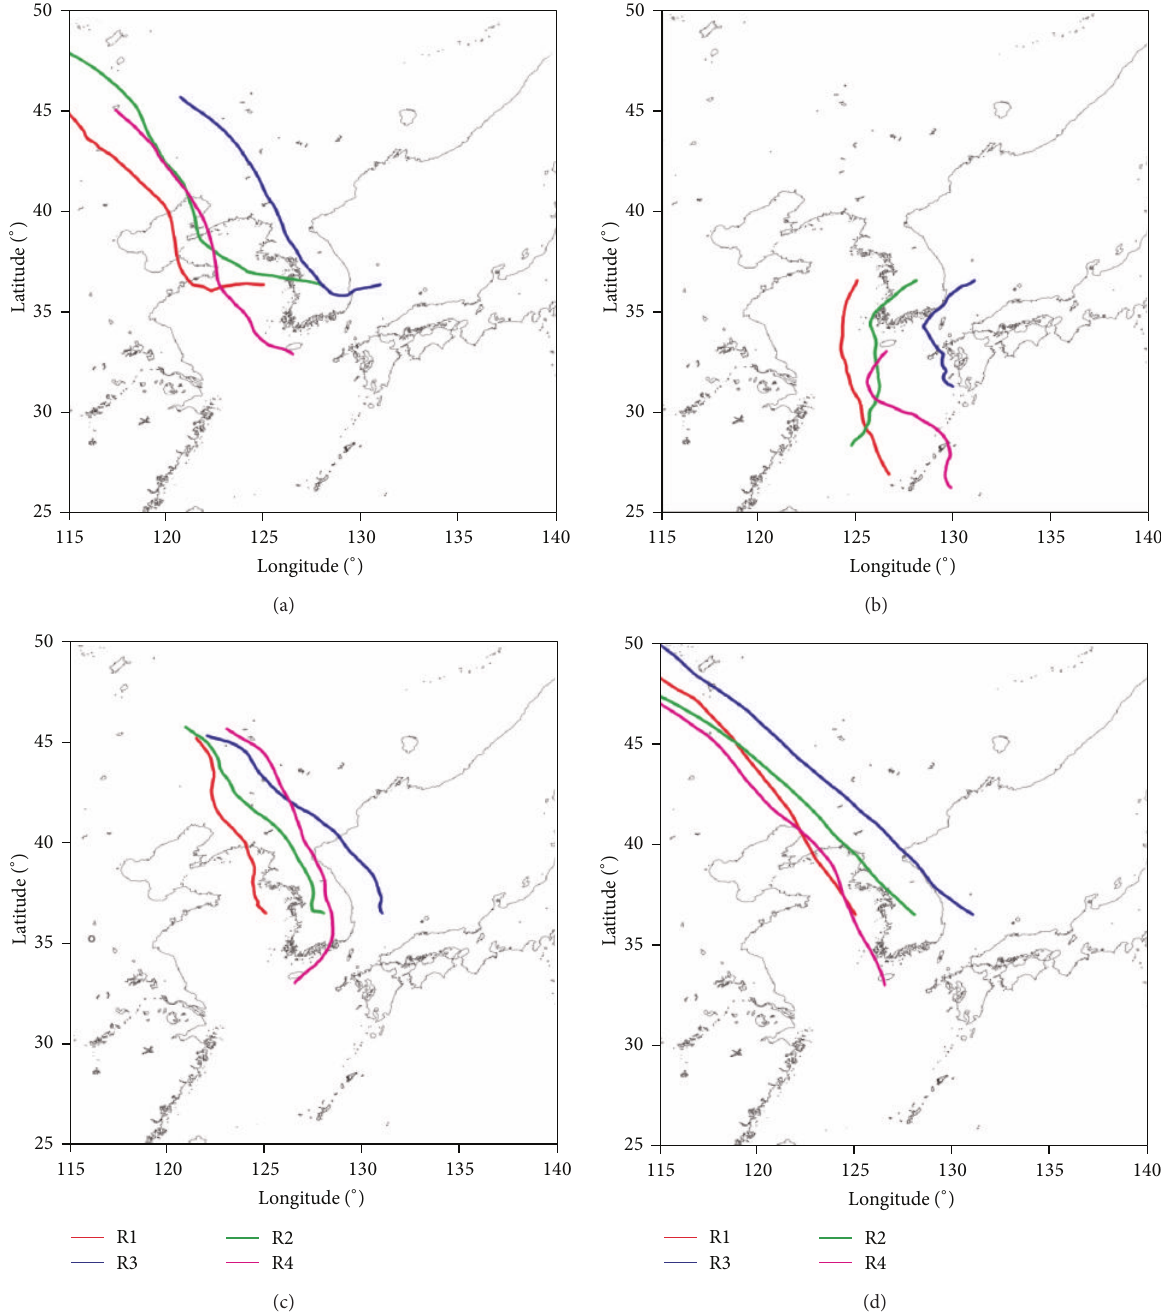
Figure 4: Climatological mean back-trajectories of the air mass arrived over R1 (red), R2 (green), R3 (blue), and R4 (pink) in (a) spring, (b) summer, (c) autumn, and (d)